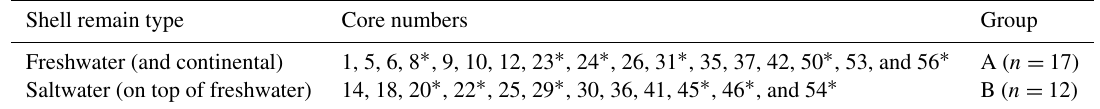
the Wormer Layer of the Naaldwijk Formation (top 5.70– 6.40 m −